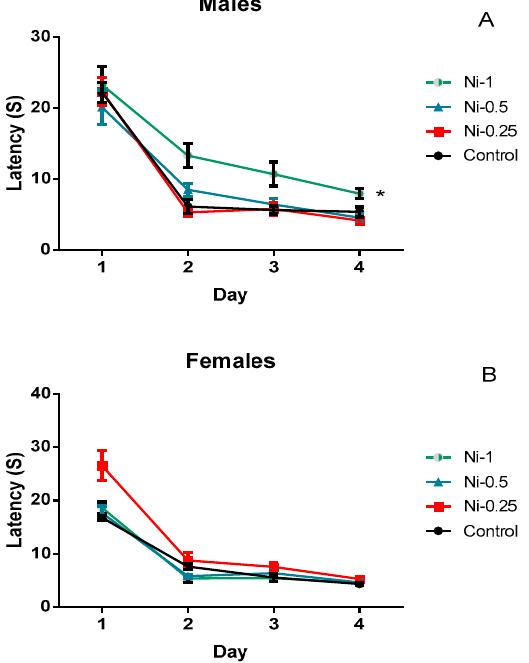
Figure 4. Latency to reach the hidden platform on each of the 4 days of learning phase in the Morris water maze, in male ( A ) and female rats ( B ) after 8 weeks of treatment with 0.9% of NaCl (Control), 0.25 mg/kg (Ni-0.25), 0.5 mg/kg (Ni-0.5), and 1 mg/Kg (Ni-1) of Ni. Results are represented as mean ± SEM. The significance level is 0.05. * p < 0.05.